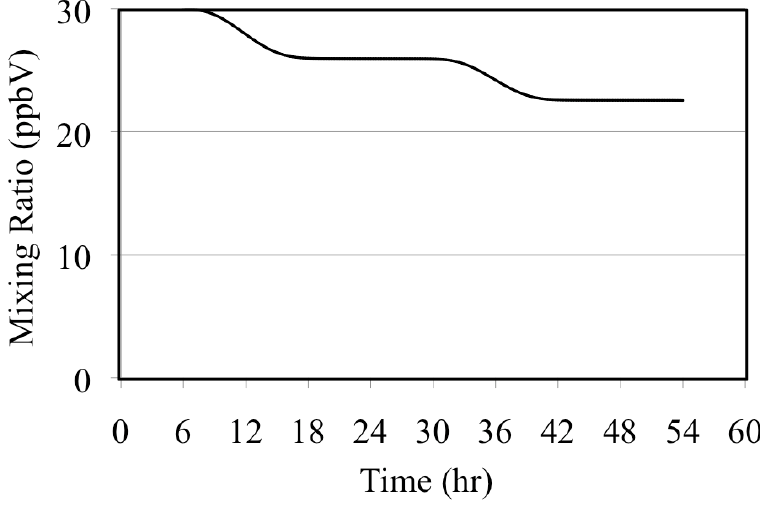
Figure 4. Ozone mixing ratios for the O